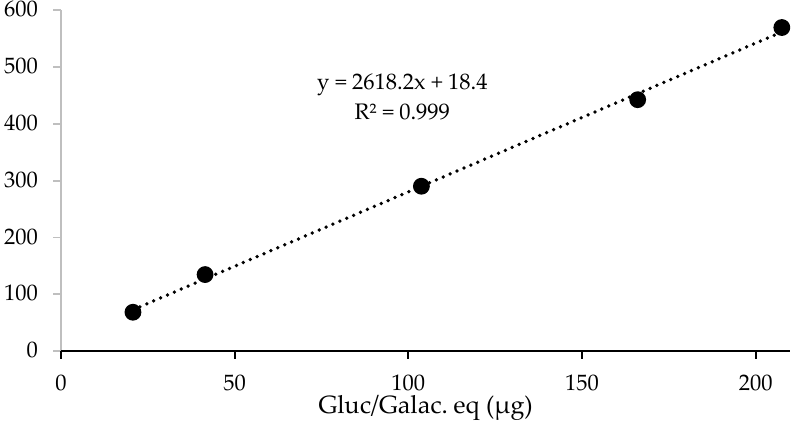
Figure 1. Linearity of response of the analytical method for glucosamine quantitation, obtained after hydrolysis and derivatization of blank samples spiked with HA.